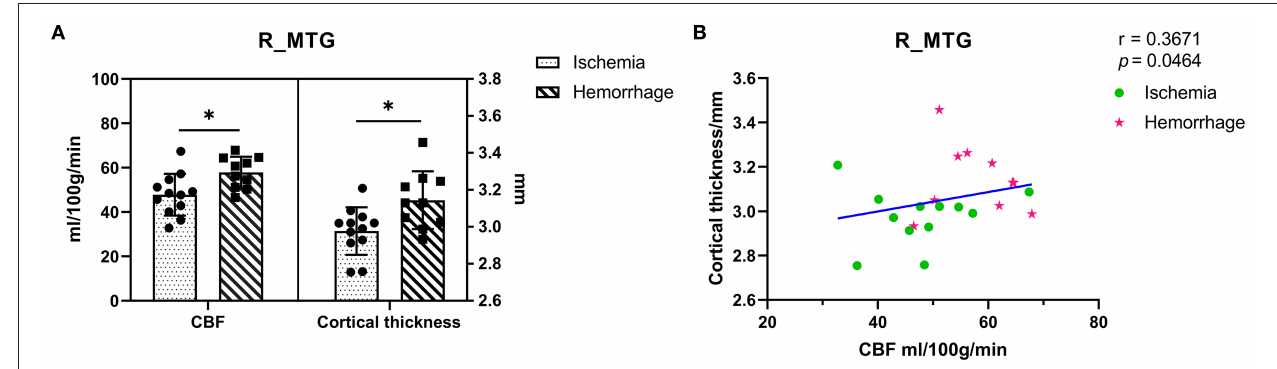
FIGURE 3 | (A) Comparison of the ASL-CBF values and cortical thickness between ischemic MMD and hemorrhagic MMD in the right MTG. The left y -axis shows the CBF values and the right y -axis shows the cortical thickness. (B) Correlation between the right MTG and its ASL-CBF within patients with MMD. L means left hemisphere. R means right hemisphere. CBF, cerebral blood flow; MTG, middle temporal gyrus. * p < 0.05.